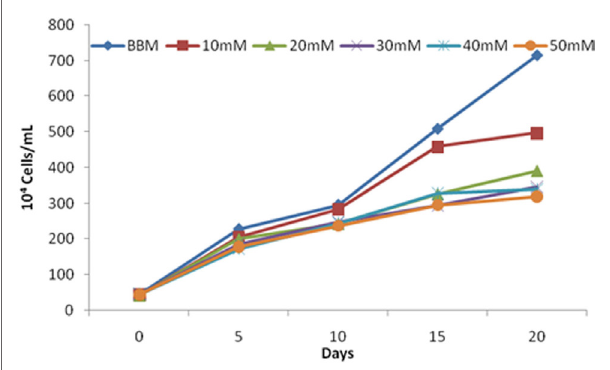
FigUre 2 | Scenedesmus quadricauda cell numbers under salt stress condition . Each bar represent different concentration of salt levels.